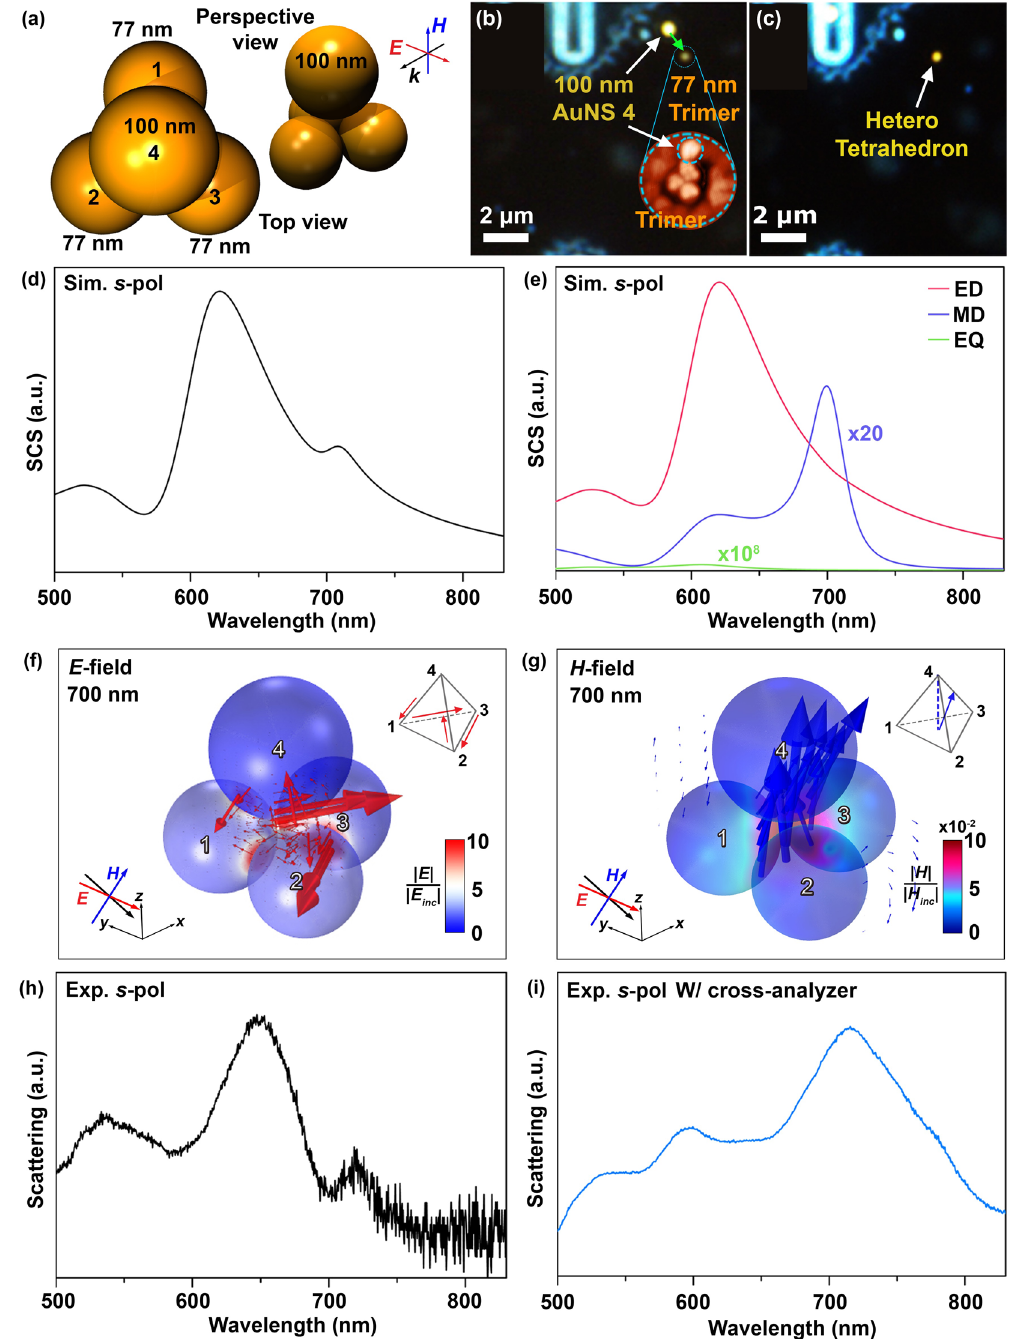
Figure 6. Electromagnetic properties of asymmetric 3D tetrahedral cluster assembled with non-equivalent AuNSs. ( a ) Schematic representation of the asymmetric 3D tetrahedral cluster assembled with non-equivalent AuNSs (three 77 nm AuNSs and a single 100 nm AuNS). ( b , c ) DFOM of the stepwise assembly of asymmetric tetrahedral cluster in ( a ): ( b ) assembly of the bottom trimer with 77 nm AuNSs and ( c ) pushing the 100 nm AuNS onto the centroid of the already-assembled trimer. ( d ) Theoretical total SCS of the asymmetric tetrahedral cluster ( a ) for s -pol. ( e ) Theoretical analysis of the relative contribution of ED, QD, and MD to the total SCS. Spatial distributions of electric ( f ) and magnetic ( g ) fields at the resonance of optical magnetism (700 nm). ( h , i ) The measured dark-field scattering spectra of the asymmetric tetrahedral cluster ( a ) with ( h ) and without ( i )